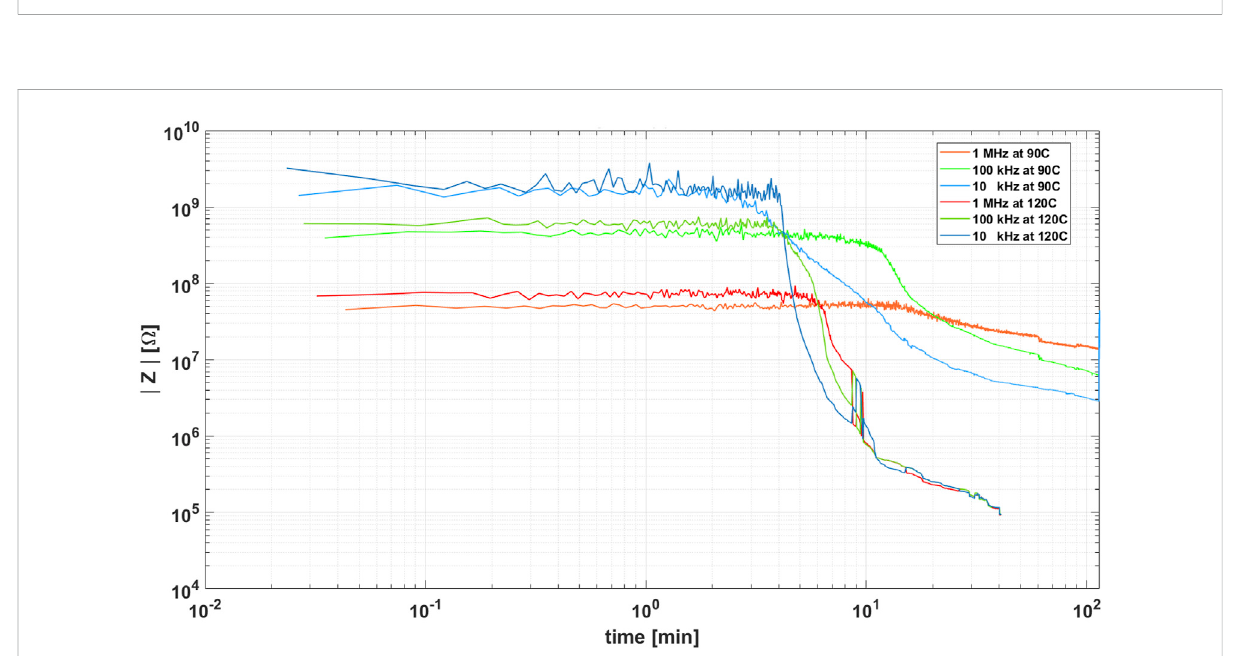
Thetemperaturein fl uencesthesintering,andthereforetherateofchangeofimpedance.Additionally,giventhatat90 ° C thesinteringspeedislower, the change in behavior of the ink from capacitive to inductive is